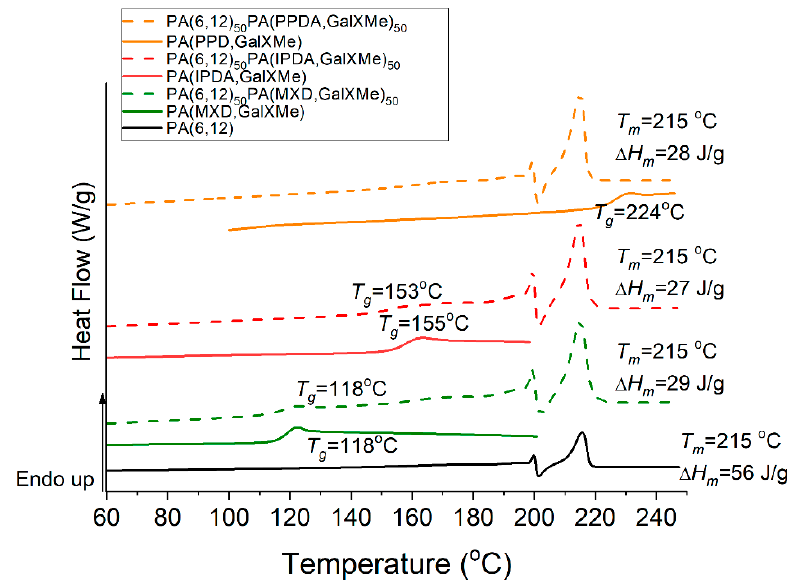
Figure 4. Differential scanning calorimetry (DSC) curves for homopolyamides and PA(6,12) blends representing heat flow (W/J) vs. temperature with endothermic exchange up.